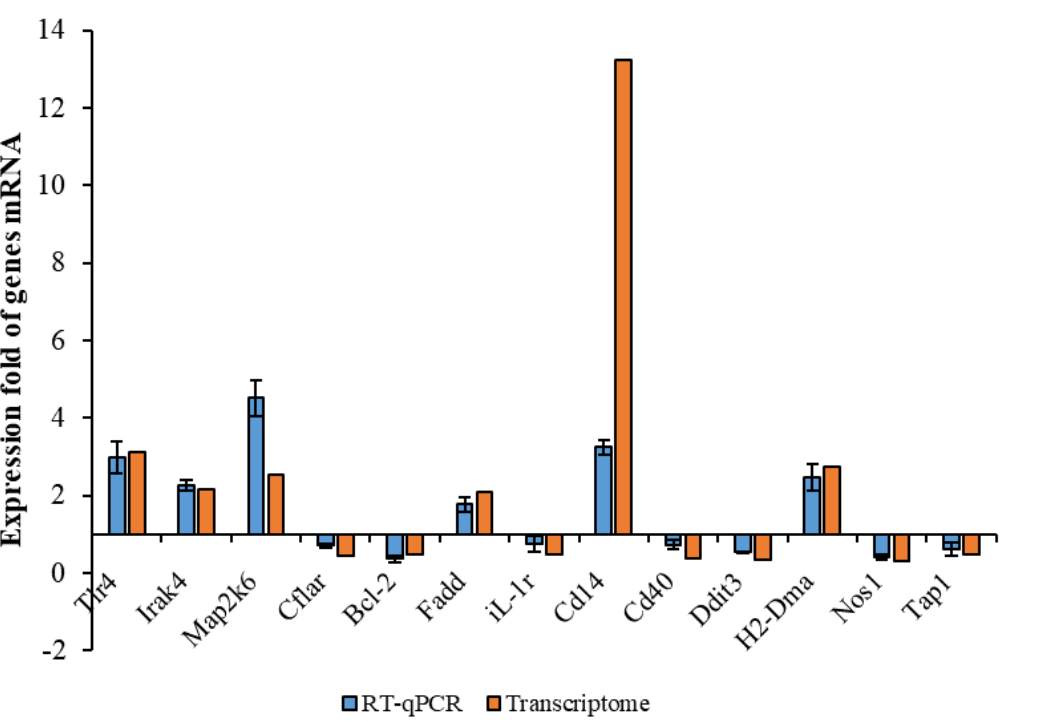
Figure 3. Comparison between transcriptome and RT − qPCR of some DEGs.